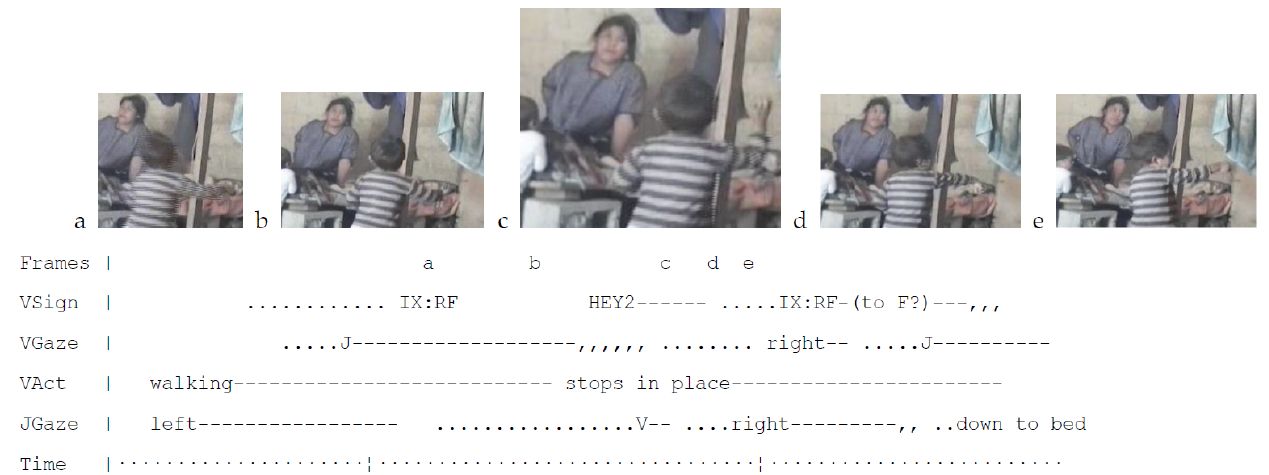
Figure 26. At 34 mos. Vic used HEY2 to direct Jane to look at something. At first, ( a ) Jane was looking away from Vic, but ( b ) she turned her attention to him as he passed with arm outstretched. The moment she gazed at him, ( c ) he raised his right arm in a demonstrative HEY2 sign, ( d ) dropping it immediately into a pointing hand, after which ( e ) Jane turned to look in the direction of his point. At 35 months, Vic was roughhousing with his uncle Will, who would pull him by the arm and try to make him do something. Vic, interacting the entire time, kept pulling away and pretending to try to escape (Figure 27). The HEY2 in Figure 27b can be understood as a feigned prelude to a similarly feigned indexical directive.